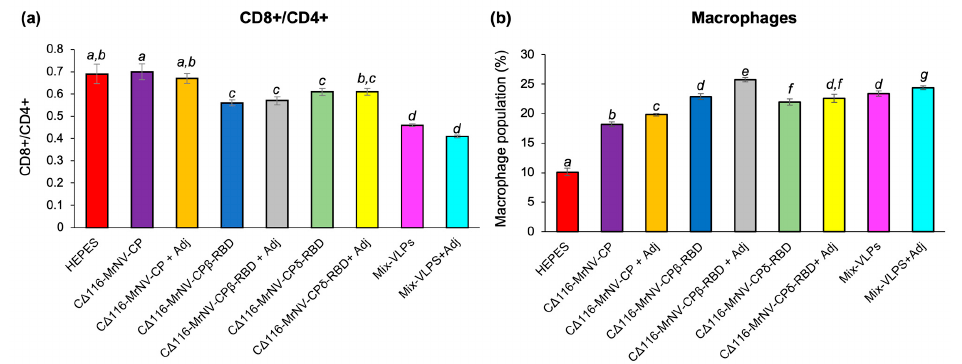
Figure 5. Immunophenotyping of mouse splenocytes. ( a ) The ratio of CD8 + /CD4 + , and ( b ) the percentage of macrophage isolated from the mouse splenocytes. Statistical significance ( p < 0.001) is denoted by italic letters shown above the bars. Insignificant differences are indicated by the same letter. Standard deviations of triplicate measurements are indicated by error bars.